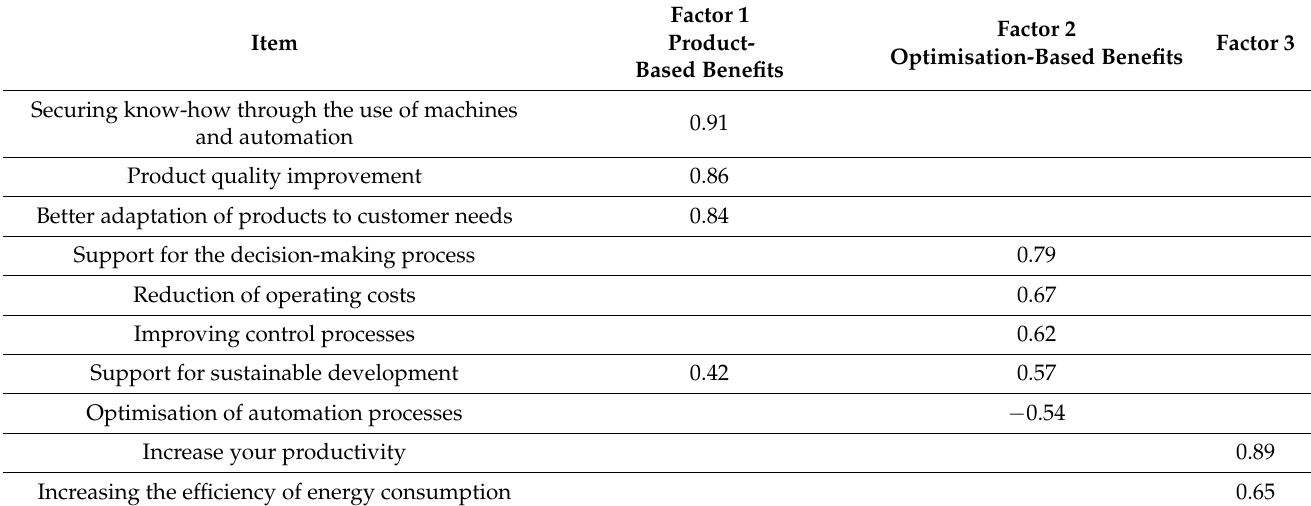
Table 10. Pattern matrix acquired in the principal component analysis regarding benefits of implementing Industry 4.0 solutions.